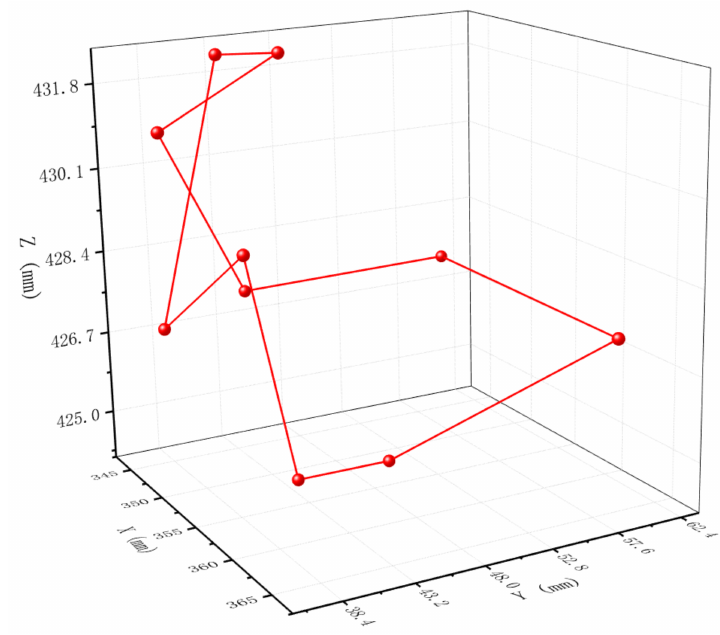
Figure 12. Selected 11-point